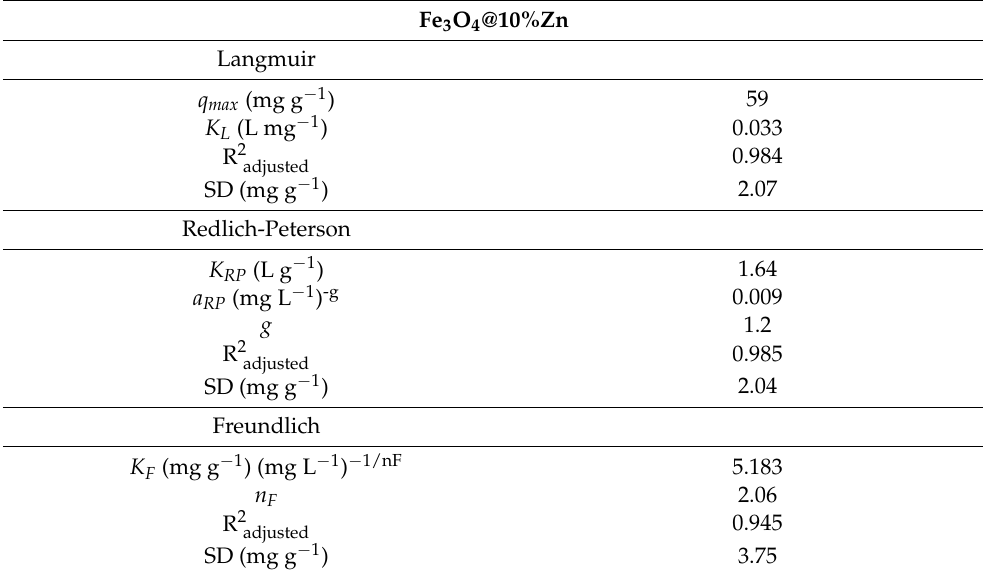
Table 6. Adsorption parameters.